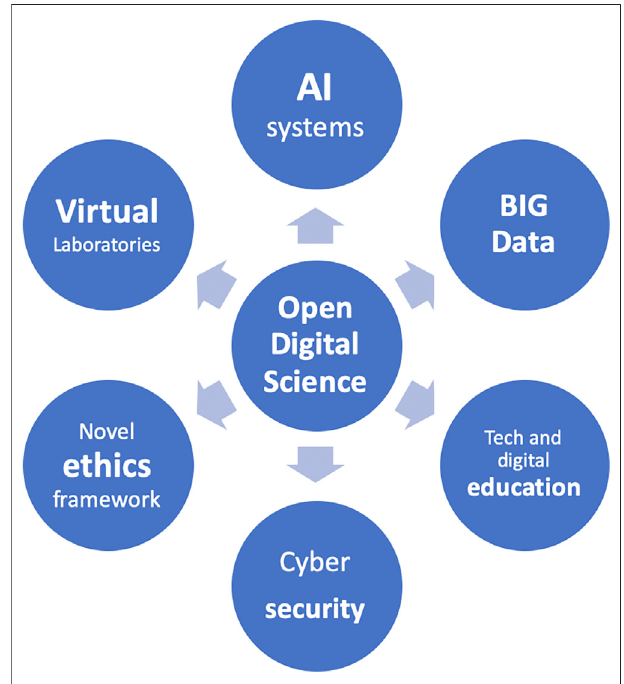
FIGURE 4 | Representation of open digital science factors. The actuationofdigitalsciencerequirestheadoptionofopenscienceprinciples,in which AI systems would be able to manage and analyze big datasets while guaranteeing high precision, quality, standardization of procedures and reproducibility of results. Moreover, data would be easily shared in real-time among the scienti fi c community through virtual laboratories and channel- based messaging/meeting platforms. In this context, the need of increased cybersecurity control would be indispensable when data are shared, to guarantee the validation of results and data security. Ethics and regulatory procedures need to be revised; a novel ethical framework should be formulated when AI systems, avatars, robots and innovative technologies become an integral part of our society. Finally, technological, digital skills